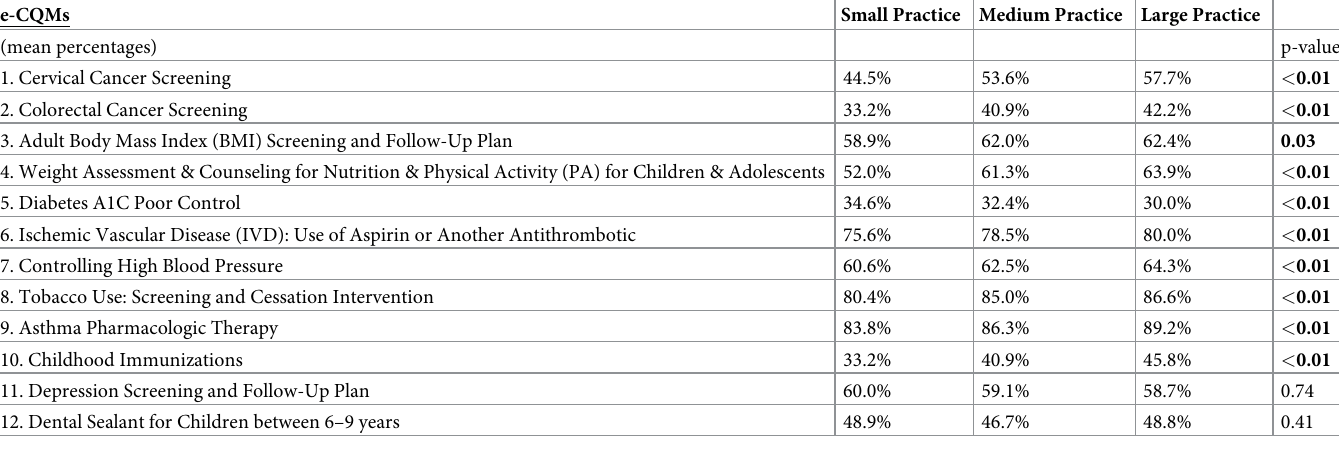
Table 3. Electronic Clinical Quality Measure (e-CQMs) performance by health center practice size.